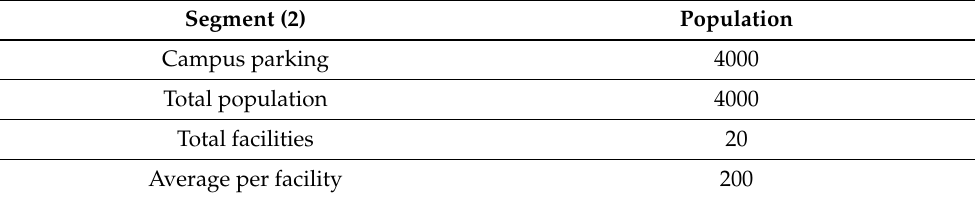
Table 4. Descriptive Statistics for Parking